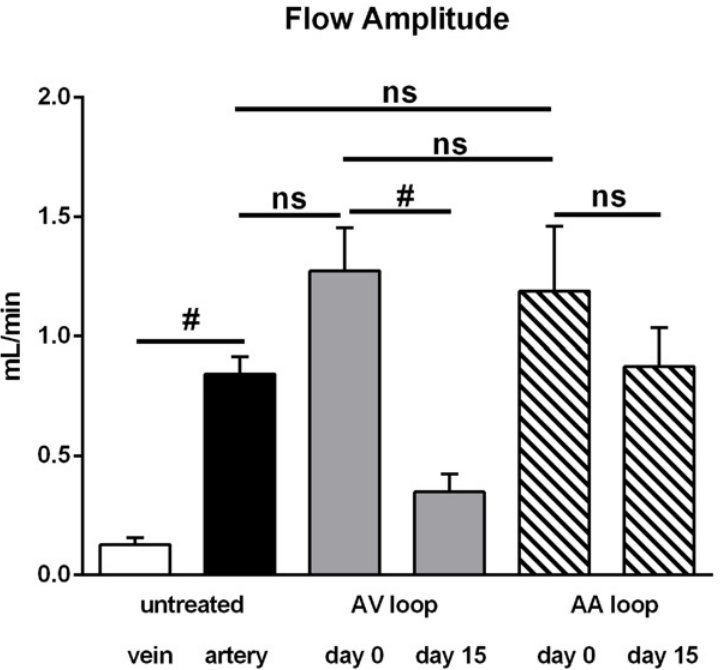
Fig 4. Flow amplitude in untreated vessels, arterioarterial (AA) and arteriovenous (AV) loops. Flow amplitude was calculated as the difference between maximal flow and the corresponding minimum value determined before from data sampled at 240 Hz. The amplitude was neglible in untreated femoral veins and significantly larger in untreated femoral arteries. Immediately after surgery (day 0), flow amplitude in AA and AV loops was at the level of untreated arteries. While the amplitude was significantly decreased in AV loops at day 15, it remained unaltered in AA loops. All values are mean+/-SEM, number of observations (n) is identical to Fig. 3. #: P <